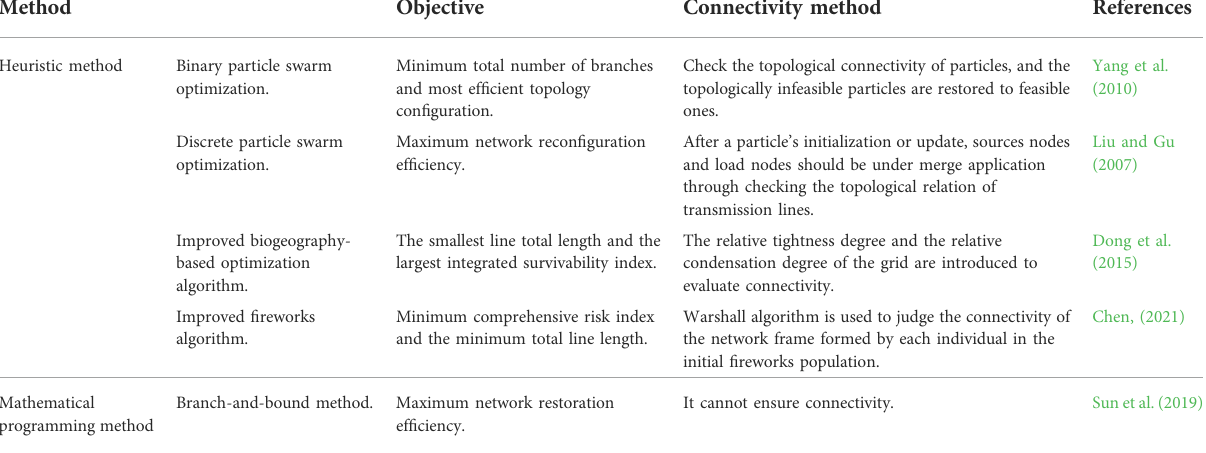
TABLE 1 Minimum backbone grid problems compared with selected